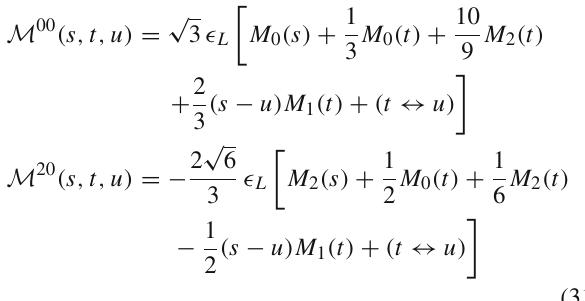
Fig. 2 Discontinuity of the γγ → πη S -wave amplitude (real part) across the π + π − cut computed using dispersive results for the γγ → ππ and ππ → ηπ amplitudes, compared to the chiral O ( p 4 ) result